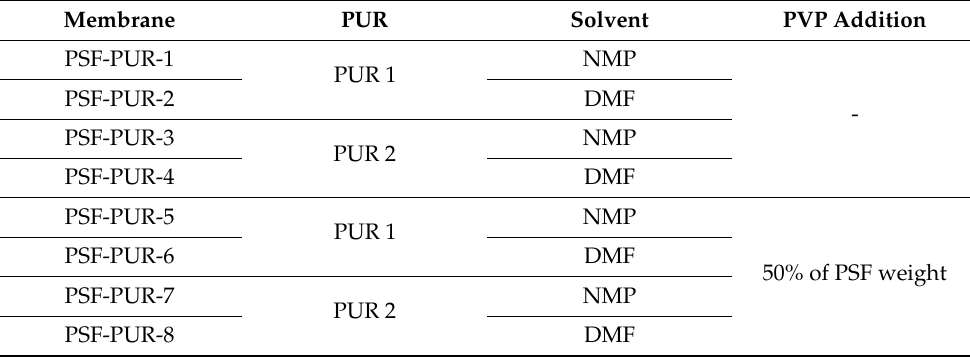
Table 1. Compositions of the membrane casting